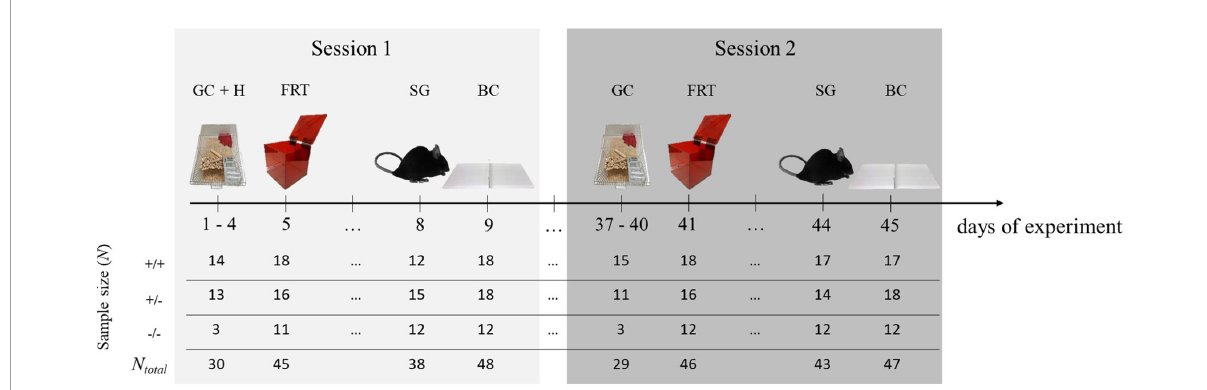
FIGURE1 Experimental design. To determine behavioral lateralization, four behaviors [grid climbing (GC), food-reaching (FRT), self-grooming (SG), and barrier crossing (BC)] were observed. Additionally, in session 1, there was a 4-day lasting habituation phase for the test box (H). To test for the temporal consistency of behavioral lateralization, mice underwent the same observations 5 weeks later. In each session, the behavior of each mouse was observed only once. At the beginning of session 1, animals were between 104 and 324 day old. At the beginning of session 2, they were between 141 and 361 days old. Sample sizes differed between the behaviors and sessions because not all mice reached the minimal number of counts per behavior (see the following sections) and therefore had to be excluded from the statistical analyses. +/+ = 5-HTT wild type mice, +/ − = 5-HTT heterozygous knockout mice, − / − = 5-HTT homozygous knockout mice.